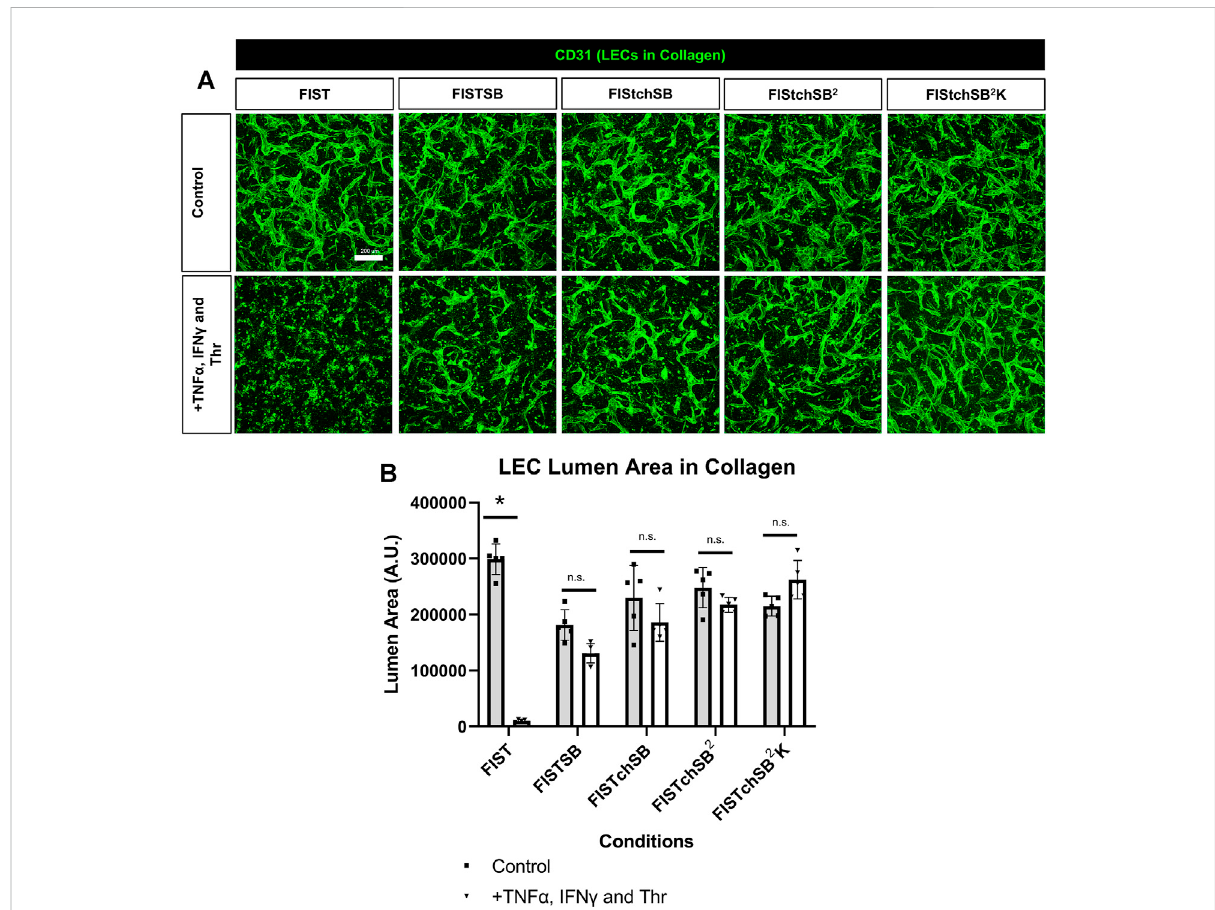
FIGURE 5 Rescuing lymphatic EC tube regression in collagen matrices induced by TNF (tumor necrosis factor) α , IFN (interferon) γ , and thrombin using combinations of pharmacologic agents. (A,B) Lymphatic endothelial cell (LEC) tube networks were established for 48 h using